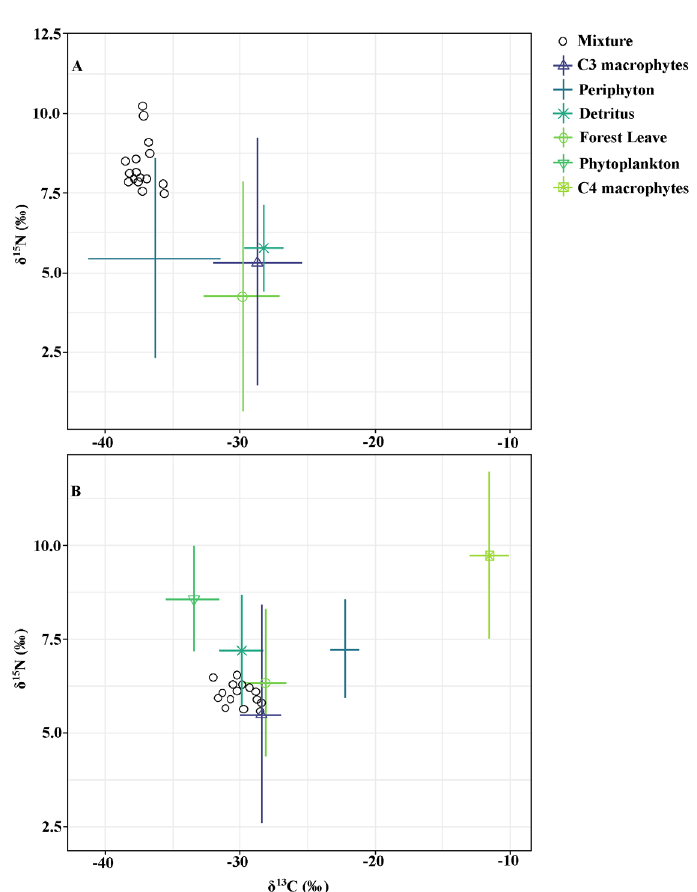
FIGURE 2 | Average δ 13 C and δ 15 N values and standard deviations of the autotrophic energy sources and Semaprochilodus insignis muscle tissue (Mixture), in Amazonas, Brazil. A. Negro River ( S. insignis adults, n = 15); B. Solimões River ( S. insignis juveniles , n = 15).